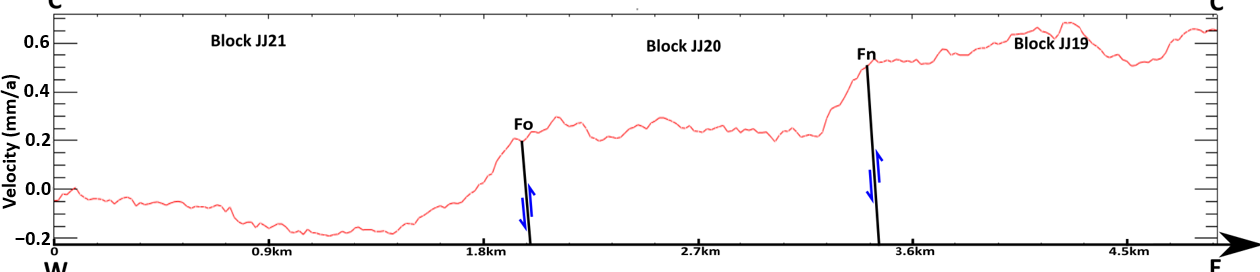
Figure 12. Vertical displacement distribution along cross-section CC’ in Figure 6. This cross-section is formed from 300 PS values sampled along the cross-section line and shows the annual relative movements within each fault block. The marked faults are interpreted from the PS, and they are illustrative, showing the sense of fault movement and general direction of faults.